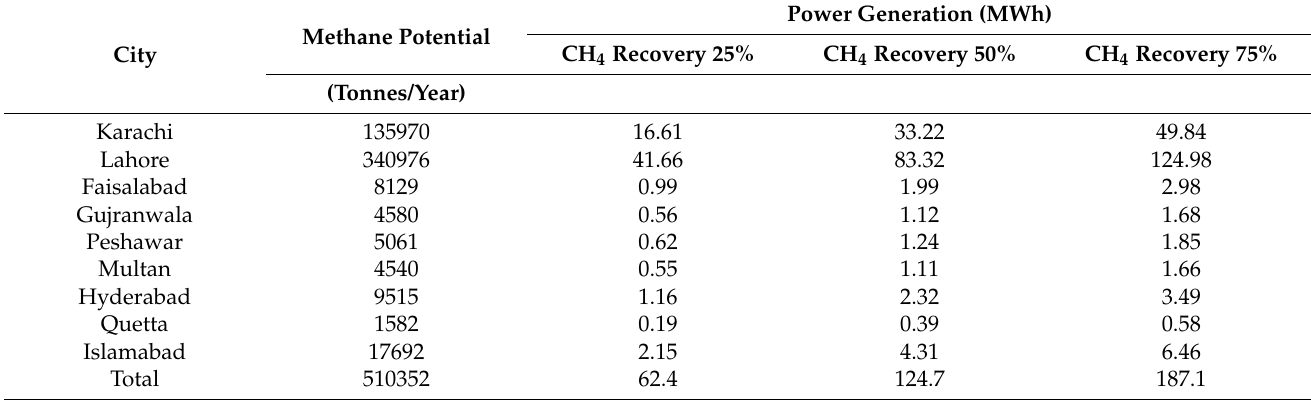
Table 9. Power generation from potential from different methane recovery